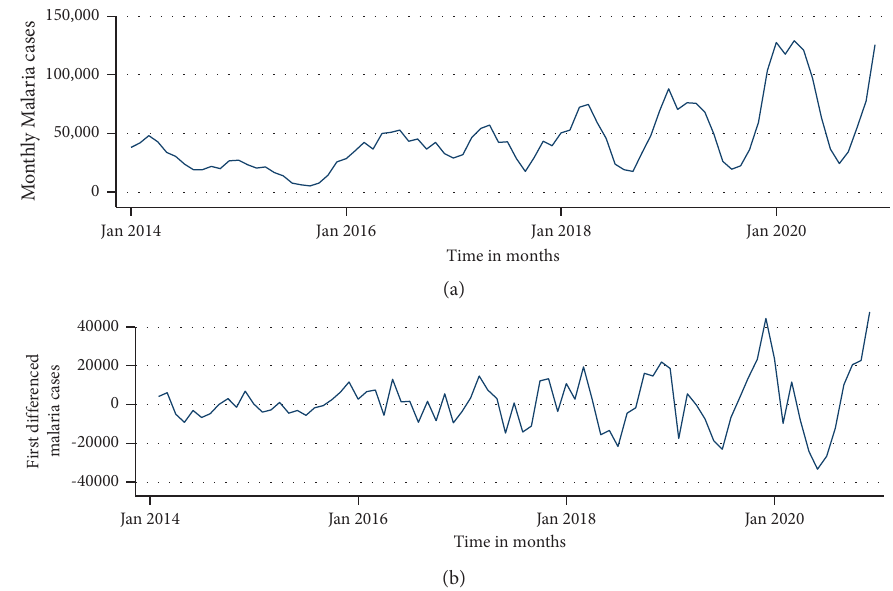
Figure 2: (a) The original monthly malaria cases. (b) First-order differenced monthly malaria cases (2014–2020).